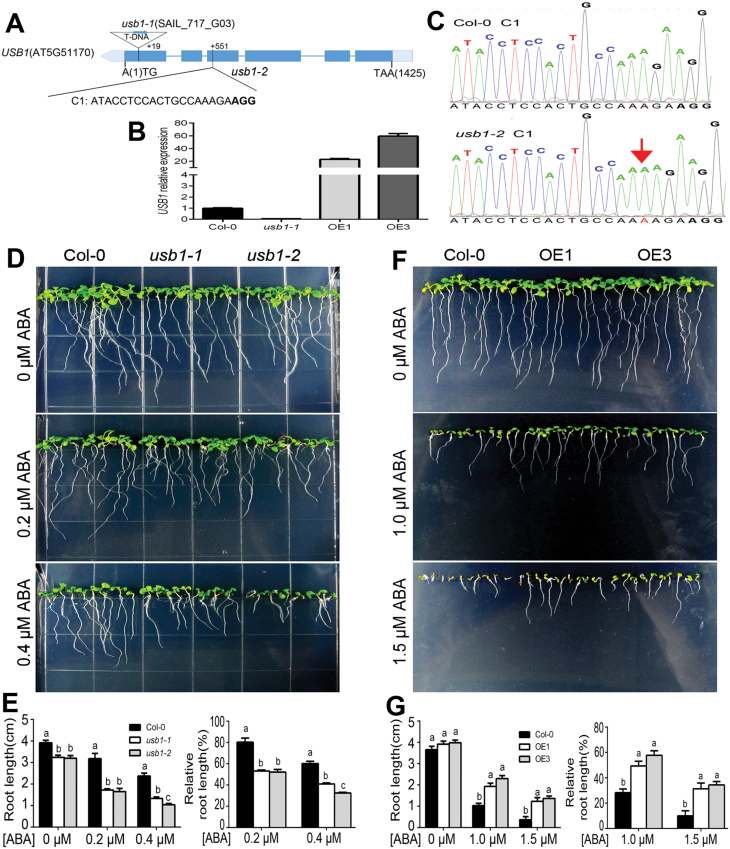
USB1 negatively regulates ABA signaling in early seedling growth. (A–C) Identification of the usb1 mutants. (A) For the usb1-1 mutant (with Col-0 background; SAIL_717_G03 from ABRC), the T-DNA was inserted into the first exon of the At5G51170 genome locus at 19 bp downstream of the start codon (ATG). Boxes and lines represent exons and introns, respectively. The usb1-2 mutant was generated by CRISPR/Cas9 technology. The target site (C1) for CRISPR/Cas9 technology is shown. Protospacer adjacent motifs (PAMs) are marked with bold letters. (B) qRT-PCR analysis of the USB1 expression level in seedlings of the 2-week-old wild-type Col-0, usb1-1, and USB1 overexpression lines OE1 and OE3. ACTIN2/8 genes were used as internal controls. The expression level of USB1 in Col-0 was standardized as one unit. Each value is the mean ±SE of three independent biological determinations. (C) The mutation in usb1-2, which was evaluated by sequencing. An adenosine insertion of the usb1-2 mutant in the USB1 gene locus at 551 bp downstream of ATG is indicated by a red letter A and an arrow. (D–G) Early seedling growth of wild-type Col-0, usb1-1and usb1-2 mutants (D, E), and Col-0, OE1 and OE3 USB1 overexpression lines (F, G). Seeds were directly planted in ABA-free MS medium (0 μM) or MS medium supplemented with different concentrations of (±)-ABA (0.2 μM and 0.4 μM in D and E, and 1.0μM and 1.5 μM in F and G), and the seedling growth was investigated 10 d after stratification at 4 °C for 3 d. (E, G) Statistical analysis of root length (left) and relative root length (right) of different genotypes described in (D) and (F), respectively. Relative values of the root length of each genotype grown on MS medium containing 0.2μM and 0.4 μM (D, E) or 1.0 μM and 1.5 μM (F, G) (±)-ABA were normalized relative to the value of the corresponding genotype at 0 μΜ ABA, which was taken as 100%. In (E, G), each value is the mean ±SE of five biological determinations, and different letters represent significant differences at P<0.05 (Duncan’s multiple range test) when comparing values within the same ABA concentration.